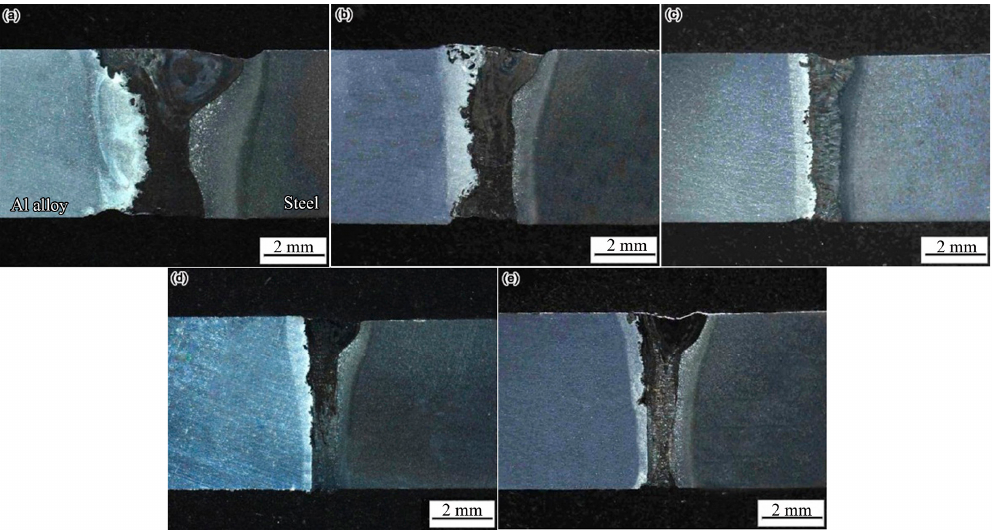
Figure 4. Effect of travel speeds on the cross-sections of Al/steel butt joints: ( a ) 0.6 m/min; ( b ) 0.8 m/min; ( c ) 1.0 m/min; ( d ) 1.1 m/min; ( e ) 1.2 m/min.